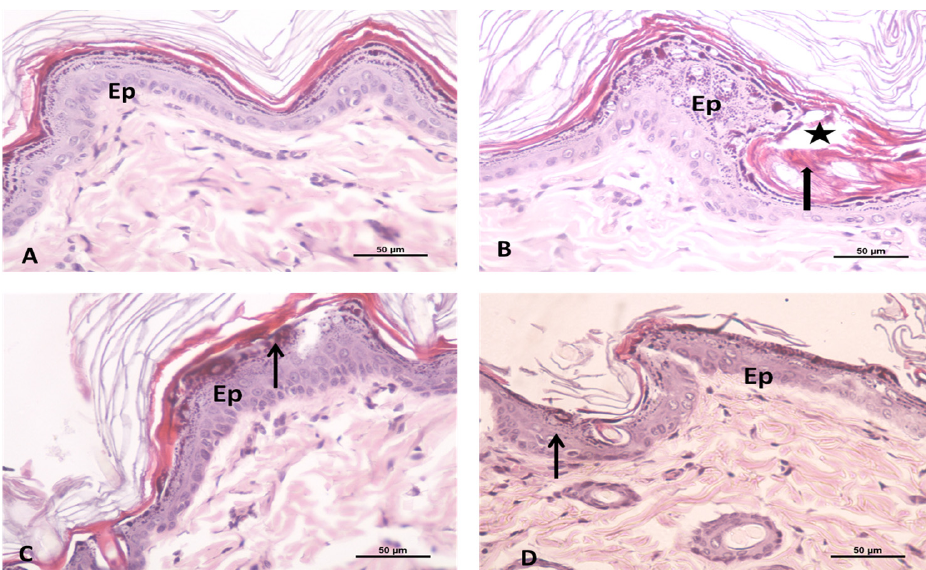
Figure 6. Photomicrograph showing the ( A ) untreated control group of rat skin: this is formed of two layers; epidermis (Ep) and dermis. The epidermal–dermal junction shows many dermal papillae; ( B ) formalin treated rat skin as a positive control group showing the thickened epidermis (Ep), invaginated keratin layer into the epidermis (thick arrow) and intercellular edema (star); ( C ) Blank NEG treated rat skin; and ( D ) ETB-NEG treated rat skin showing the moderately thickened epidermis (Ep) and the presence of little reaction ( ↑ ). H&E 400 ×